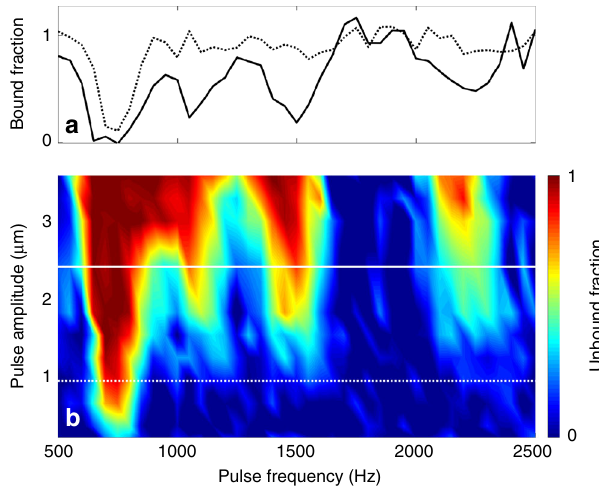
Fig. 2 Spectroscopy of the quantum simulator. a Remaining bound fraction as a function of carrier frequency for pulses with τ = 250 ms, ϕ = π , and amplitudes of 0.9 μ m (dotted) and 2.4 μ m (solid). Note the emergence of higher-order peaks and power broadening at larger amplitudes. b Unbound fraction as a function of applied pulse frequency and amplitude, for a 250 ms pulse. Lines indicate cuts plotted in a